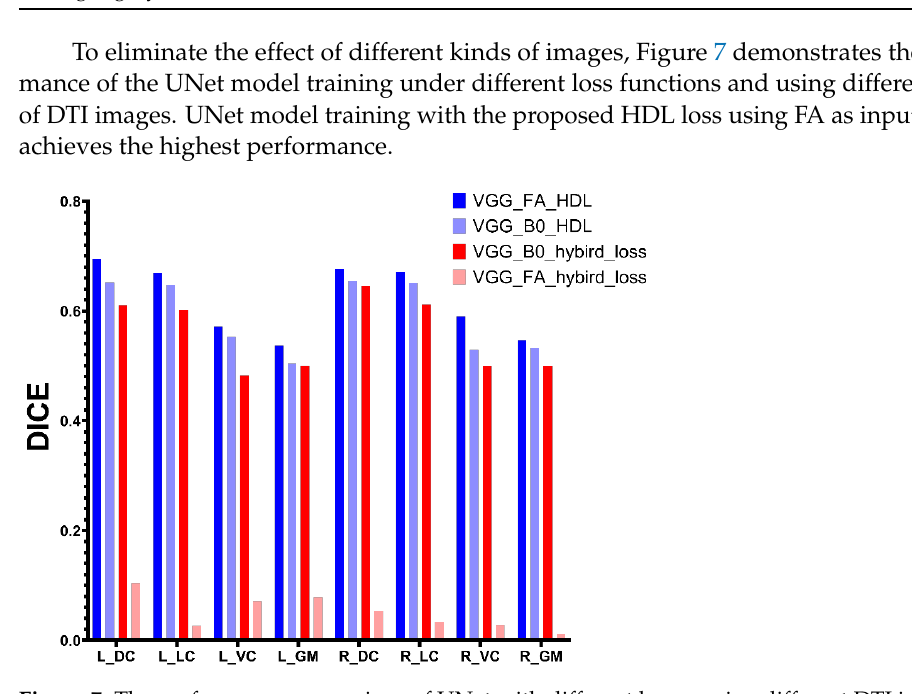
Figure 7. The performance comparison of UNet with different losses using different DTI images.